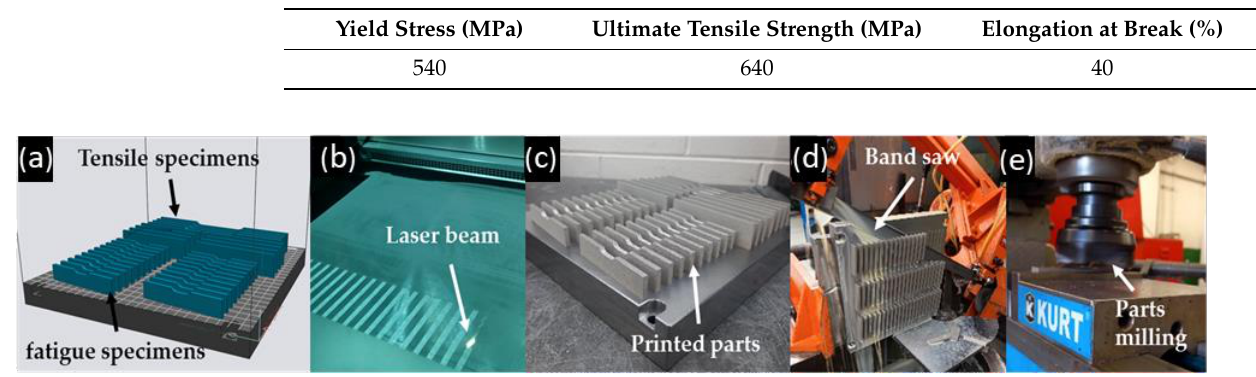
Figure 3. Additive manufacturing specimen preparation, ( a ) STL file preparation with EOSPRINT, ( b ) parts building, ( c ) finished print, ( d ) parts cutting, ( e ) supported surface machining.